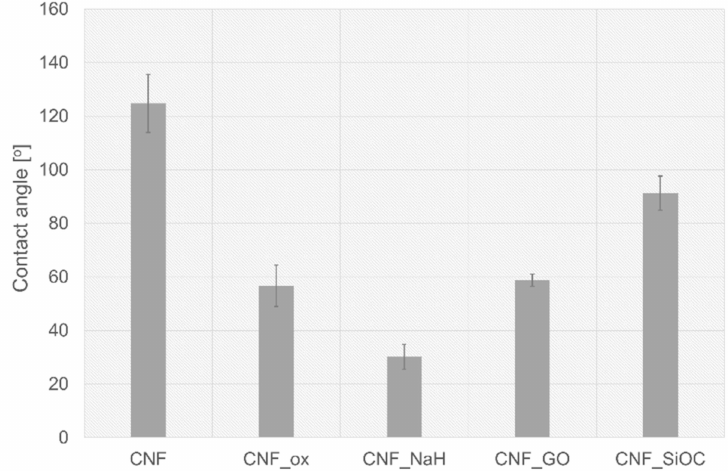
Figure 7. Water contact angle values for as-received CNF, and CNF after